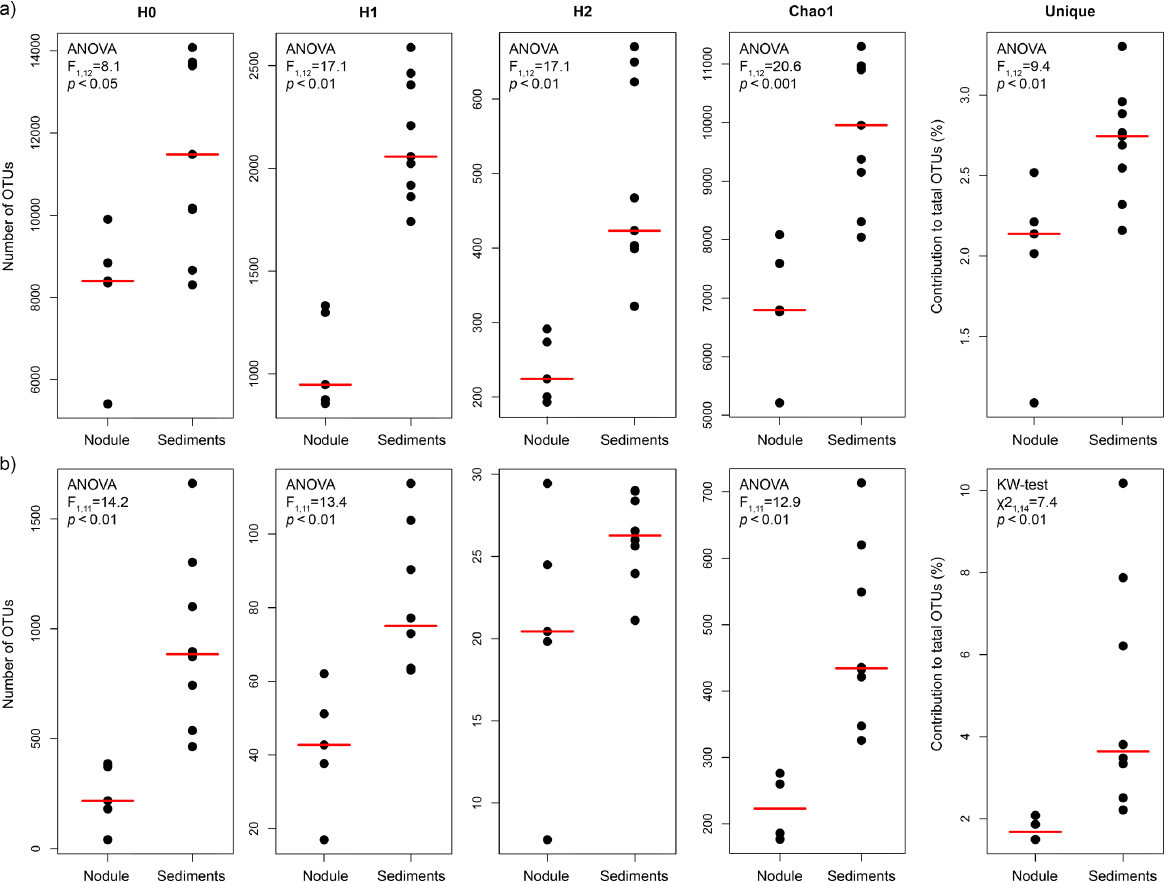
Figure 1. Comparison of diversity indices and unique OTUs between manganese nodules and sediments for (a) bacterial and (b) archaeal communities. H 0 : number of OTUs ( q = 0); H 1 : exponential Shannon ( q = 1); H 2 : inverse Simpson ( q = 2); unique: OTUs present exclu- sively at each station (percentage relative to total OTUs of whole dataset). Chao1 and Unique OTUs were calculated with 100 sequence resamplings per sample for the smallest dataset (40613 sequences for Bacteria and 1835 sequences for Archaea). The red line shows the median. F : statistic F ratio, with subscript numbers reporting the degrees of freedom between groups and within groups, respectively; p : probability level; KW test: Kruskal–Wallis test; χ 2 : chi-square test value, with subscript numbers reporting the degrees of freedom between groups and sample size,